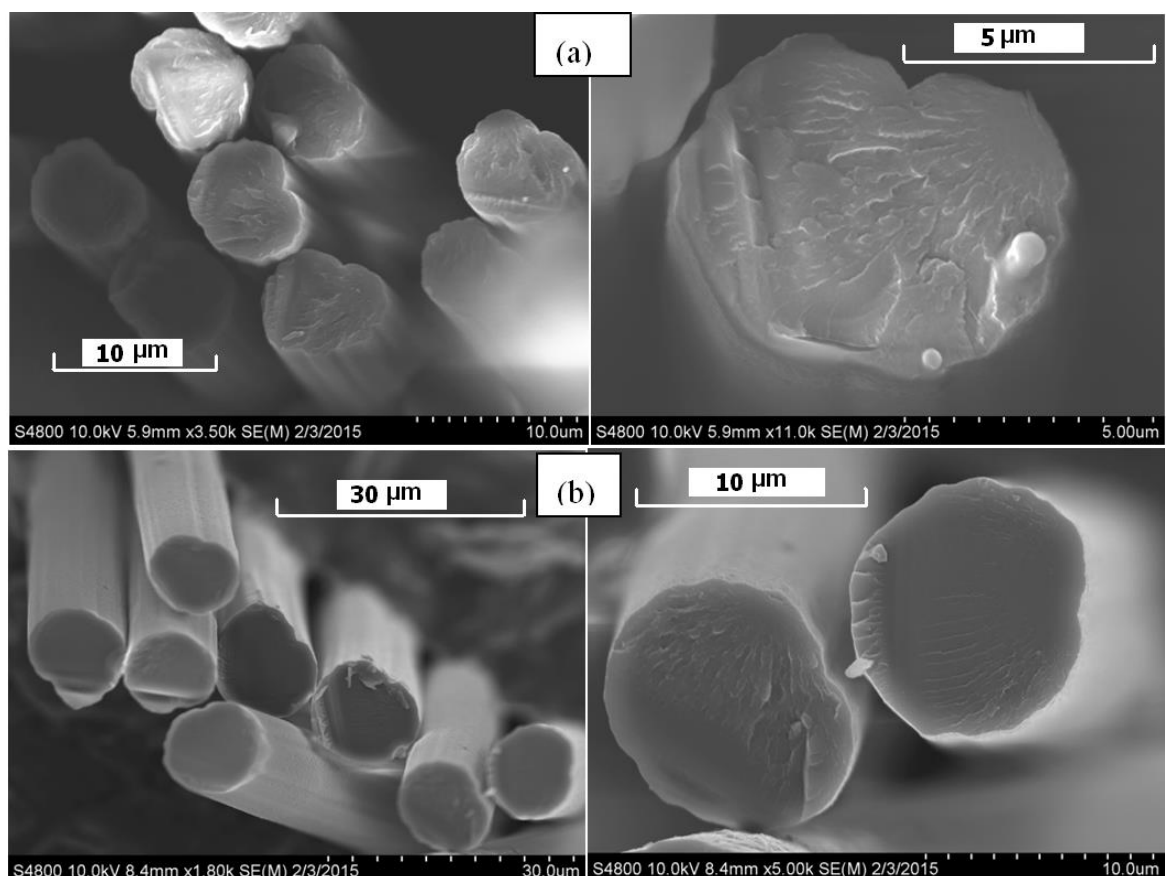
Figure 9. SEM images of stabilized Ace-SKL fibers ( a ) fibers without any prior UV treatment stabilized at a slow rate of 0.2 °C/min; ( b ) fibers with 15-min prior UV treatment stabilized at a fast rate of 1.2